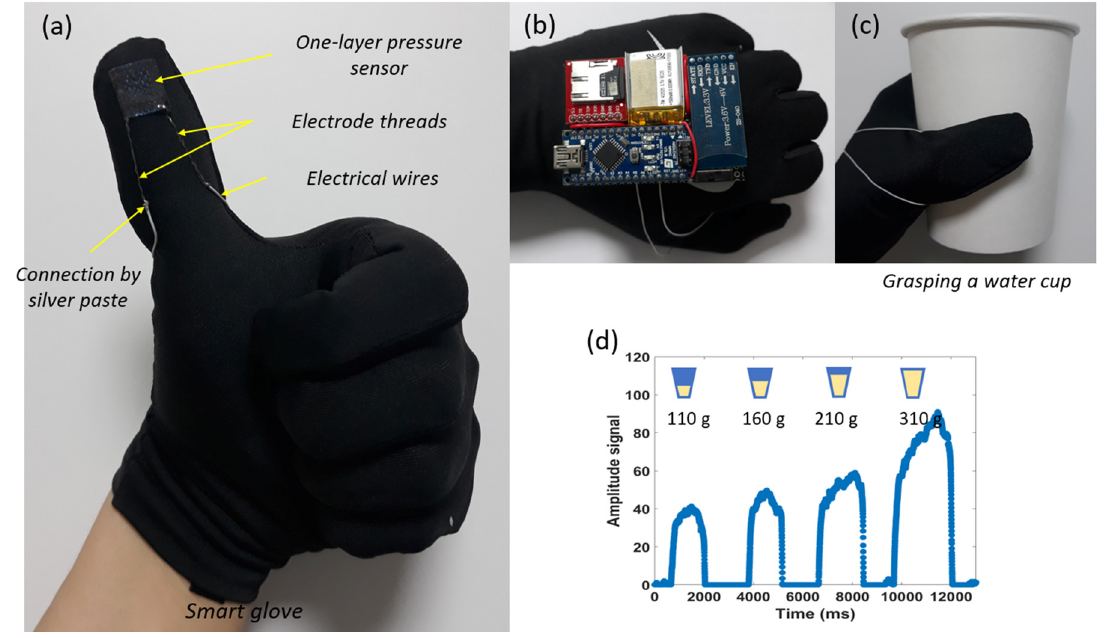
Figure 9. Smart glove application of the sensor, consisting of ( a ) structure of the sensing finger on glove, ( b ) hardware platform, ( c ) grasping a water cup, and ( d ) the change in signal amplitude when the subject grasps the different weights.